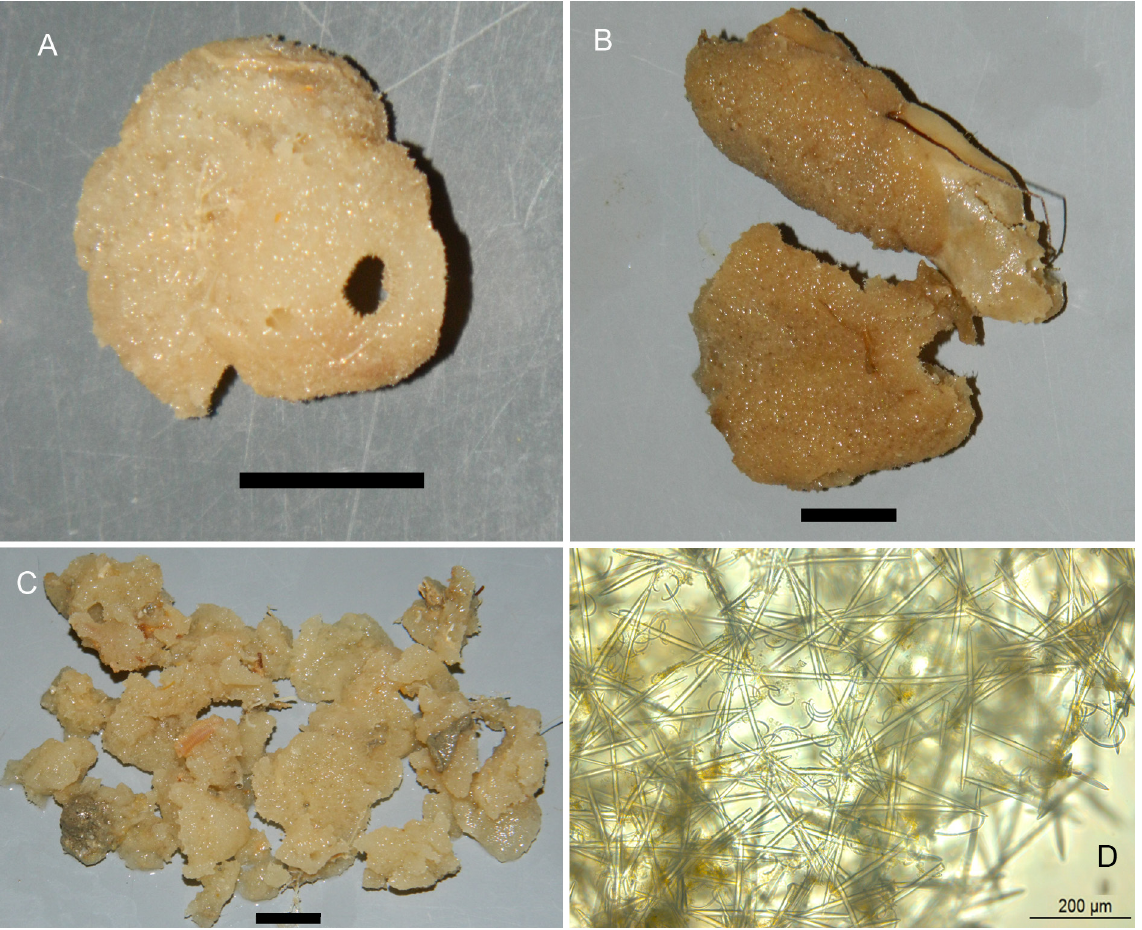
Fig. 15. Haliclona ( Flagellia ) hajdui subgen. et sp. nov., from the Guyana Shelf, off Suriname. A . Habitus of holotype (RMNH Por. 9921). B . Habitus of paratype (RMNH Por. 9851). C . Habitus of paratype (RMNH Por. 9783). D . Light microscopic image of surface skeleton of holotype (RMNH Por. 9921), showing scattered flagellosigmas and sigmas. Scale bars = 1